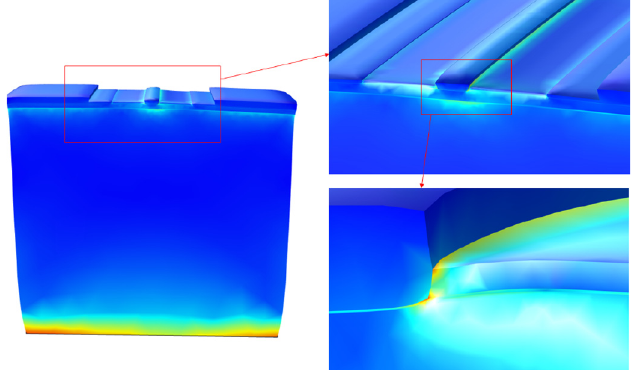
Fig. 9. Distribution of von Mises stresses in the HEMT structure. the red color indicates the areas with maximum stresses, and the blue color indicates the